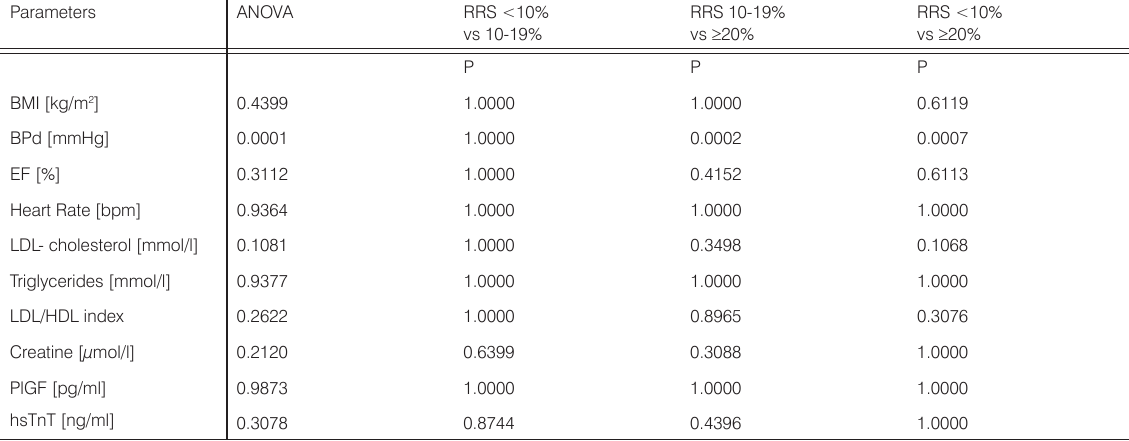
Table 3. Results of comparison of Reynolds Risk Score (RRS) groups- analysis of variance ANOVA Kruskal- Wallis test. Parameters